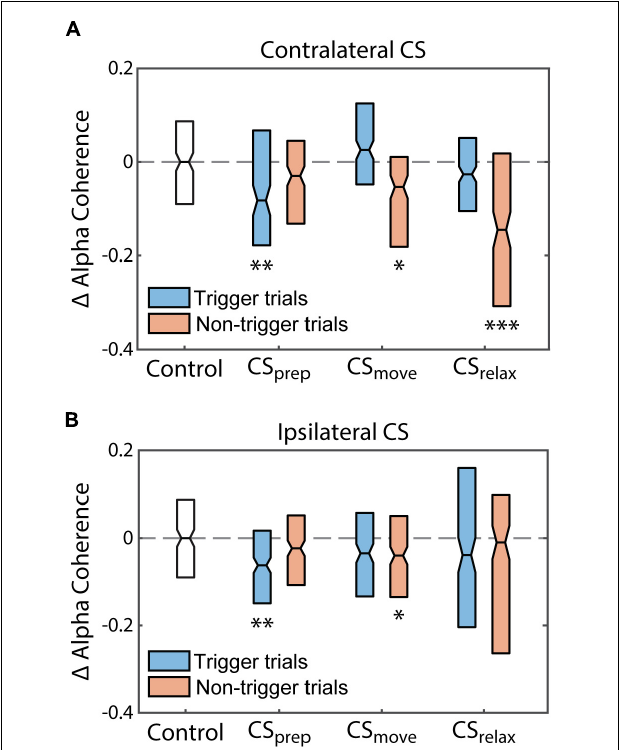
FIGURE 12 | Alpha coherence reflects changes in RT. Normalized changes in the integrated interhemispheric alpha coherence peak from the Pre epoch to the Cond epoch (difference between the coherence in the Pre and Cond epochs divided by the coherence in the Pre epoch). The changes in alpha coherence reflect the changes in Monkey U’s RT induced by each CS timing for (A) Contralateral CS and (B) Ipsilateral CS. Statistical testing compares the changes to the control experiment. ( ∗ p < 0.01, ∗∗ p < 0.001, ∗∗∗ p < 0.0001).